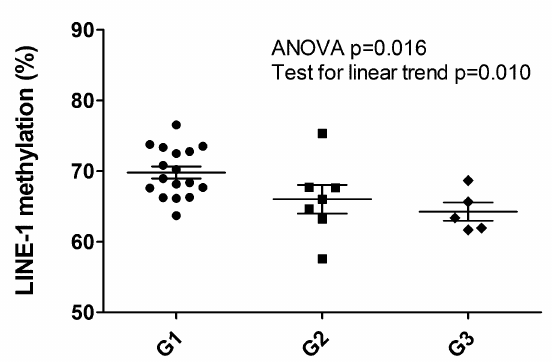
Figure 3. LINE-1 hypomethylation analysis of 29 PanNET samples (28 primary and one